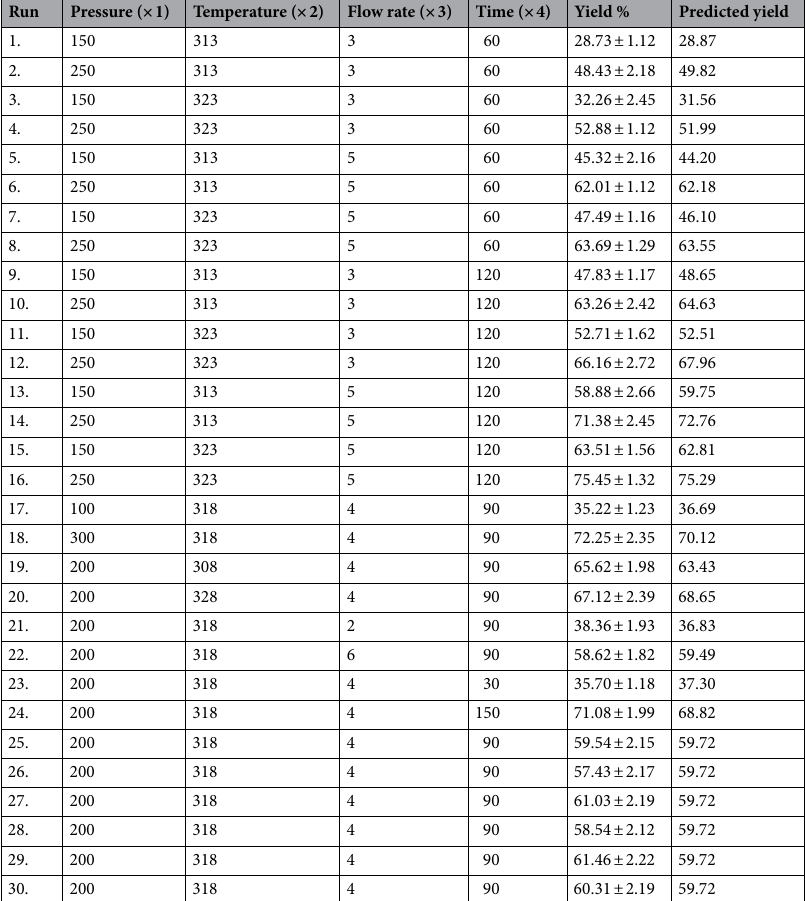
Table 2. Experimental results and predicted yields obtained from